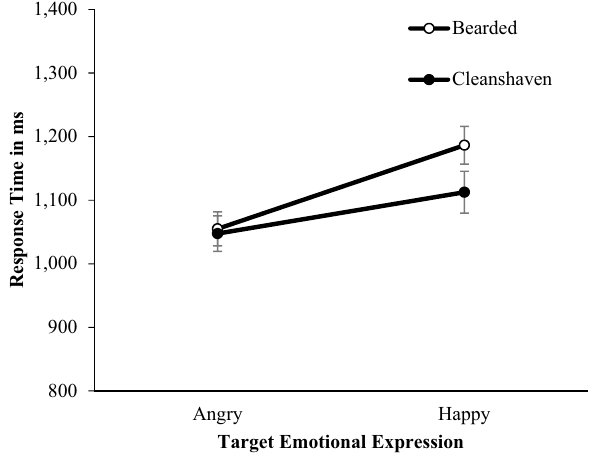
Figure 5. Mean response times for Study 2 indicating the presence or absence of target angry or happy expressions in neutral backgrounds. Error bars are ± 1